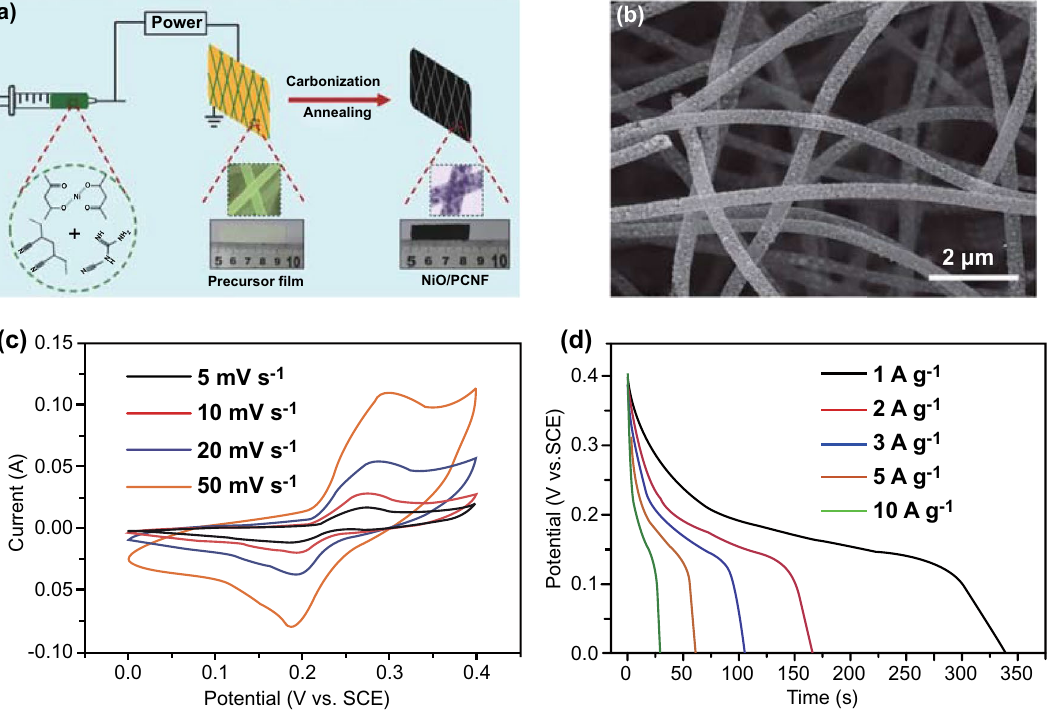
Fig. 4 a Schematic illustration of the synthesis of free-standing NiO/PCNF composite film. b , c and d SEM images, CV curves, and discharge voltage profiles of NiO/PCNF-0.75. Adapted with permission from Ref. [36] Copyright 2018